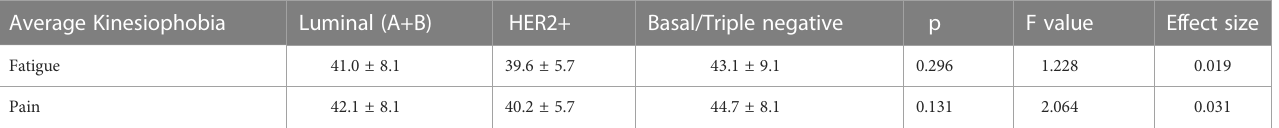
TABLE 6 Level of kinesiophobia and type of